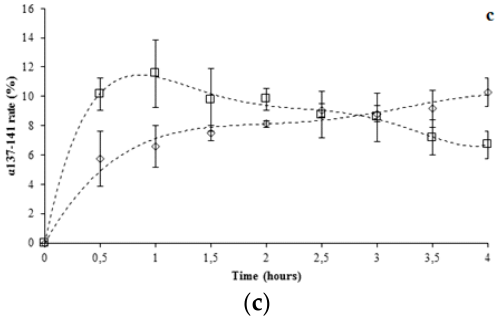
Figure 2. Recovery of total peptides ( a ) and α 137-141 ( b ), and evolution of α 137-141 rate ( c ) during the electrodialysis with ultrafiltration membrane (EDUF) treatment with and without pH control at 4.7.